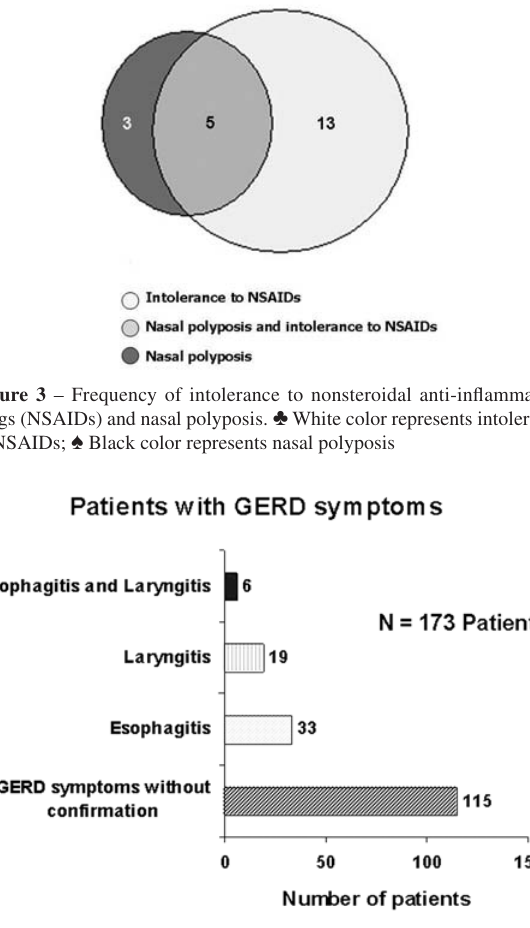
Figure 4 – Patients with gastroesophageal reflux disease (GERD) symptoms and investigation with esophagogastroduodenoscopy (EGD) and videolar- yngoscopy. Confirmation of GERD was based on findings of esophagitis or